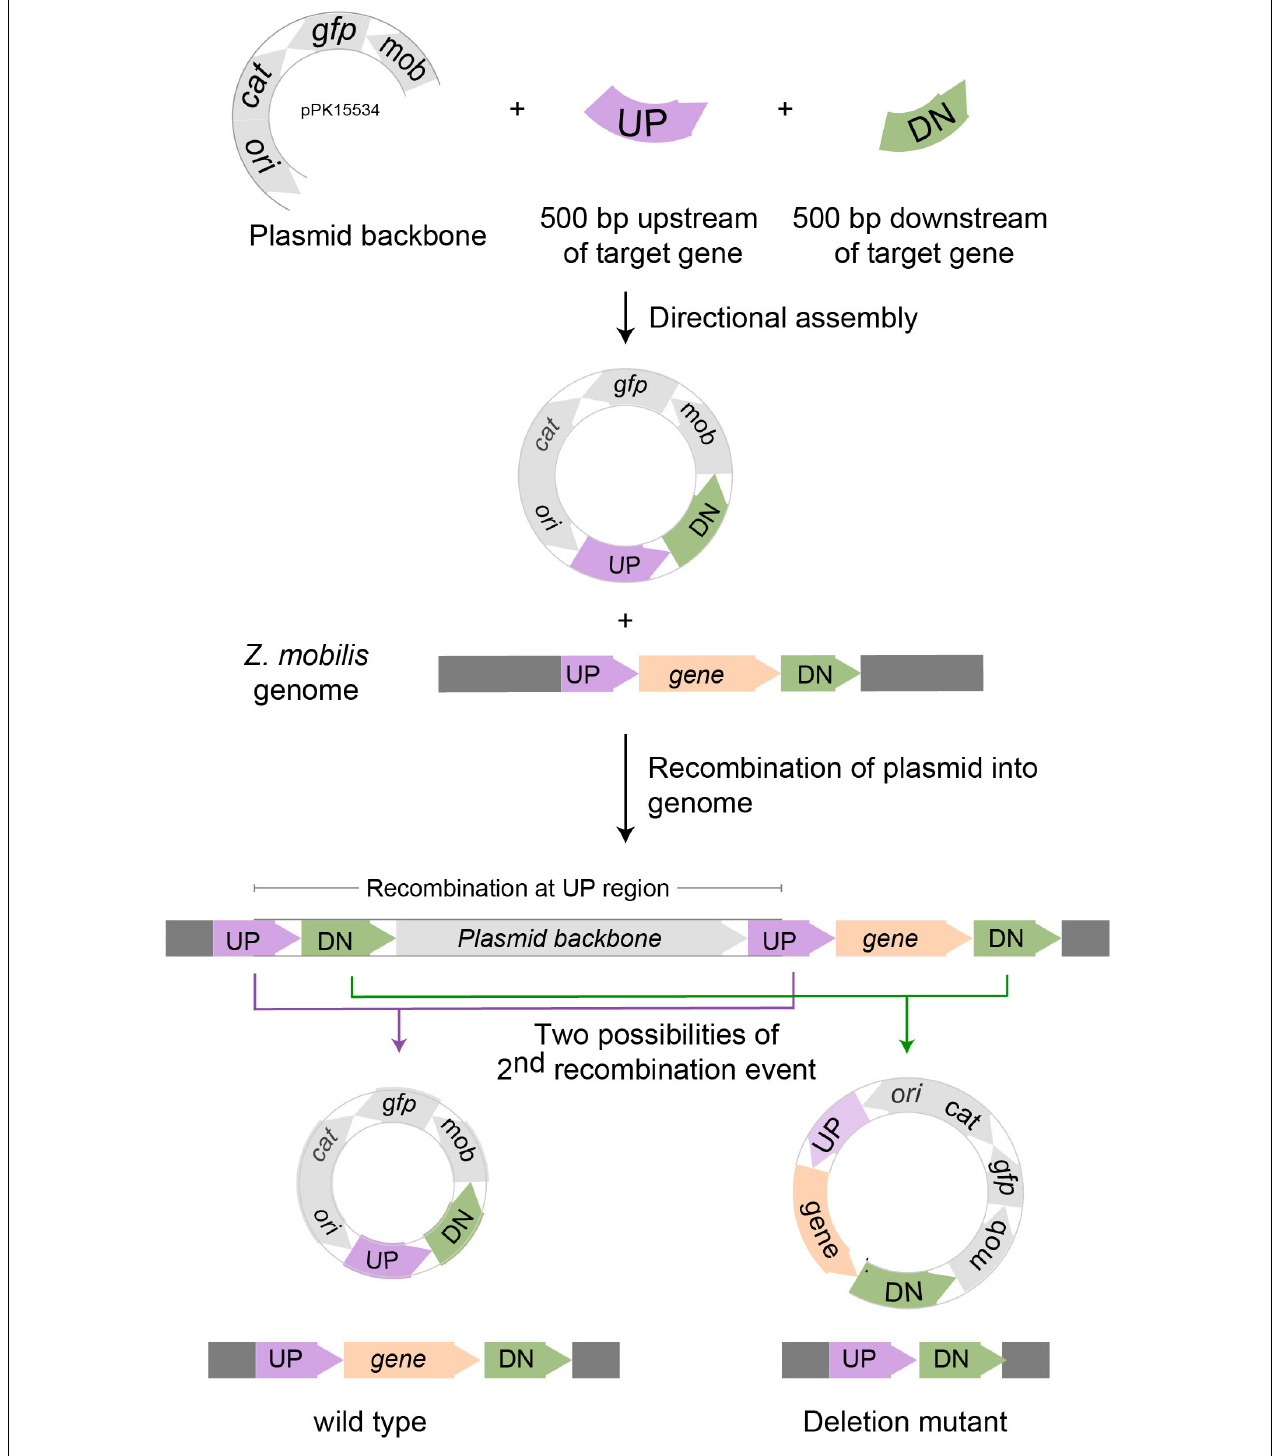
FIGURE 2 | Scheme for deleting genes in Z. mobilis . Deletion of a gene in Z. mobilis is accomplished by cloning 500 bp of DNA from upstream (UP) of and downstream (DN) of the gene to be deleted into the suicide plasmid pPK15534. Next, the plasmid is introduced into Z. mobilis by conjugation and single crossover homologous recombination events are selected for with chloramphenicol. Shown here is a crossover that occurred at the UP location, but recombination at the DN location is equally possible. Lastly, growing cells without selection allow detection of a second recombination event that results in plasmid loss by screening for the loss of fluorescence from GFP. Wild-type and deletion mutant genotypes were distinguished by PCR amplification.